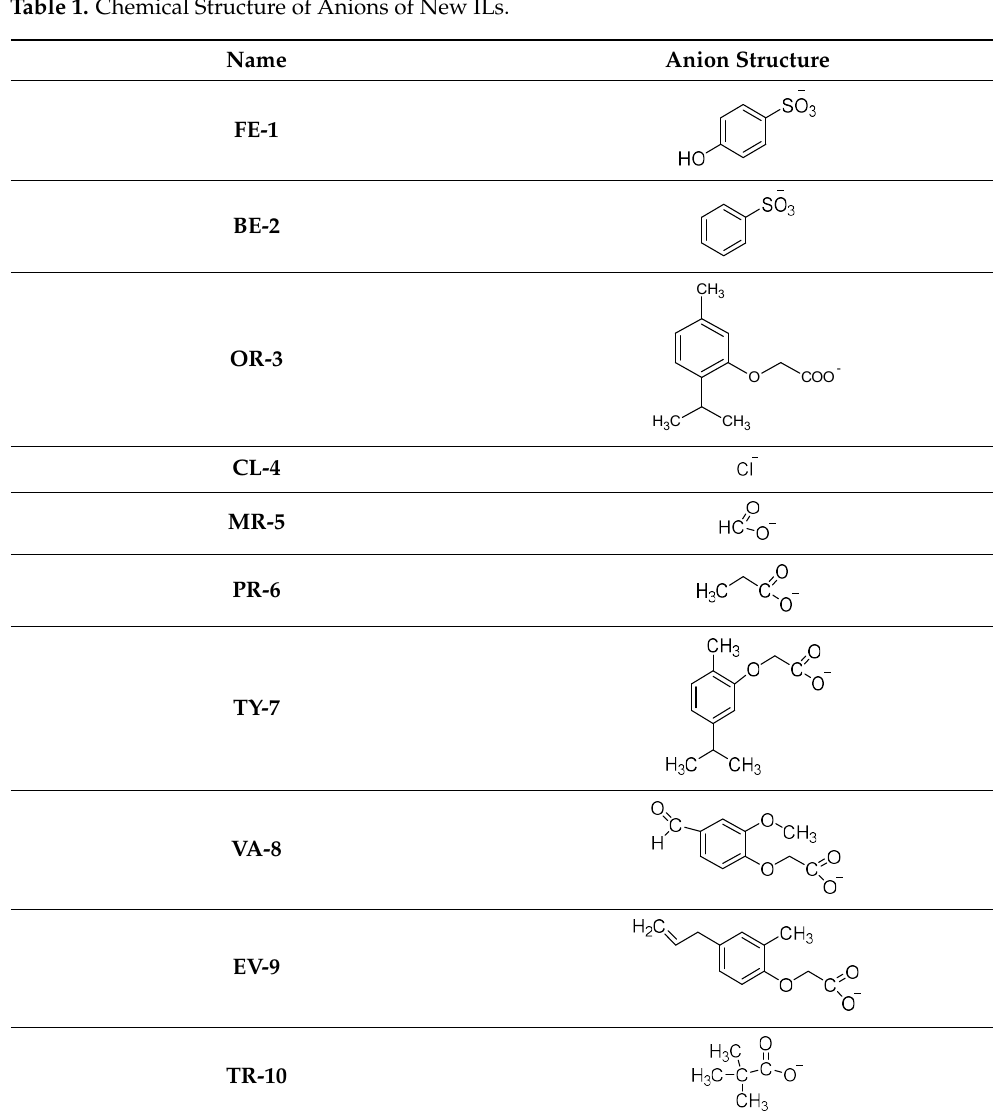
Table 1. Chemical Structure of Anions of New ILs.